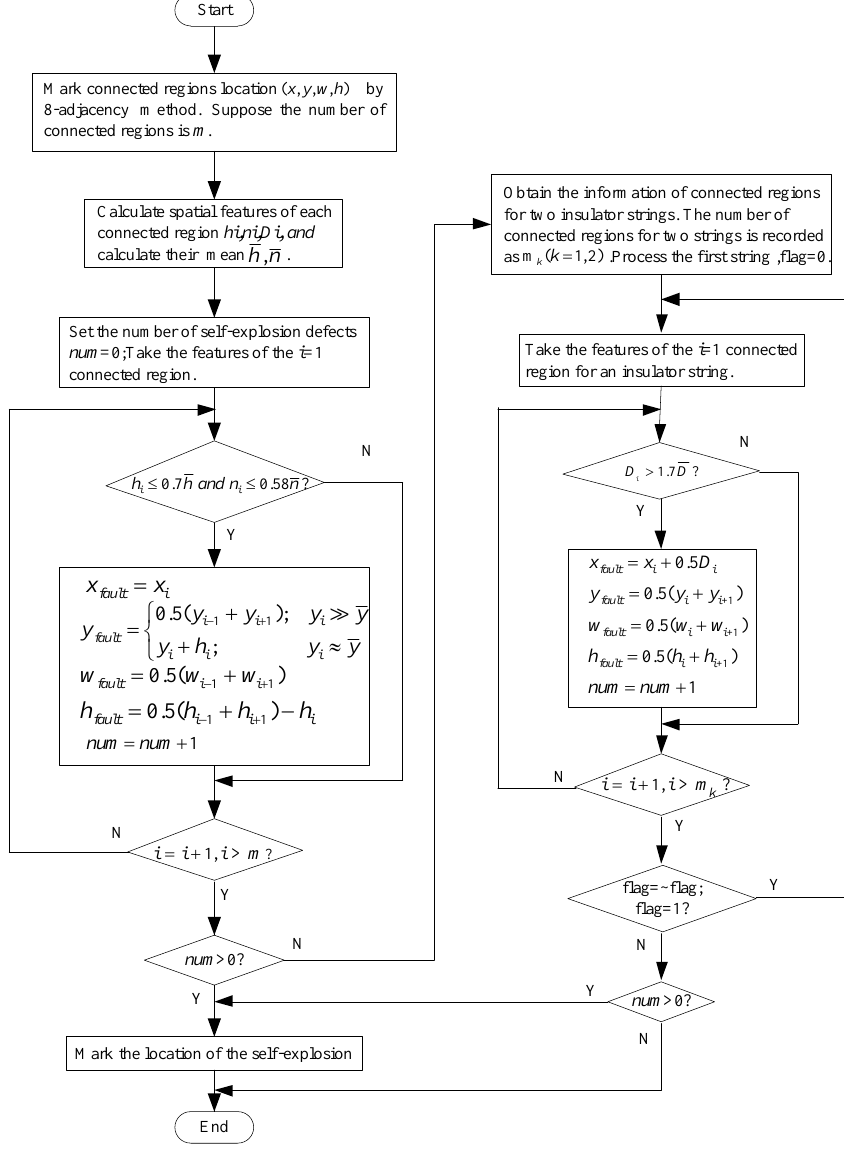
Figure 6. Flow chart of the proposed detection method.